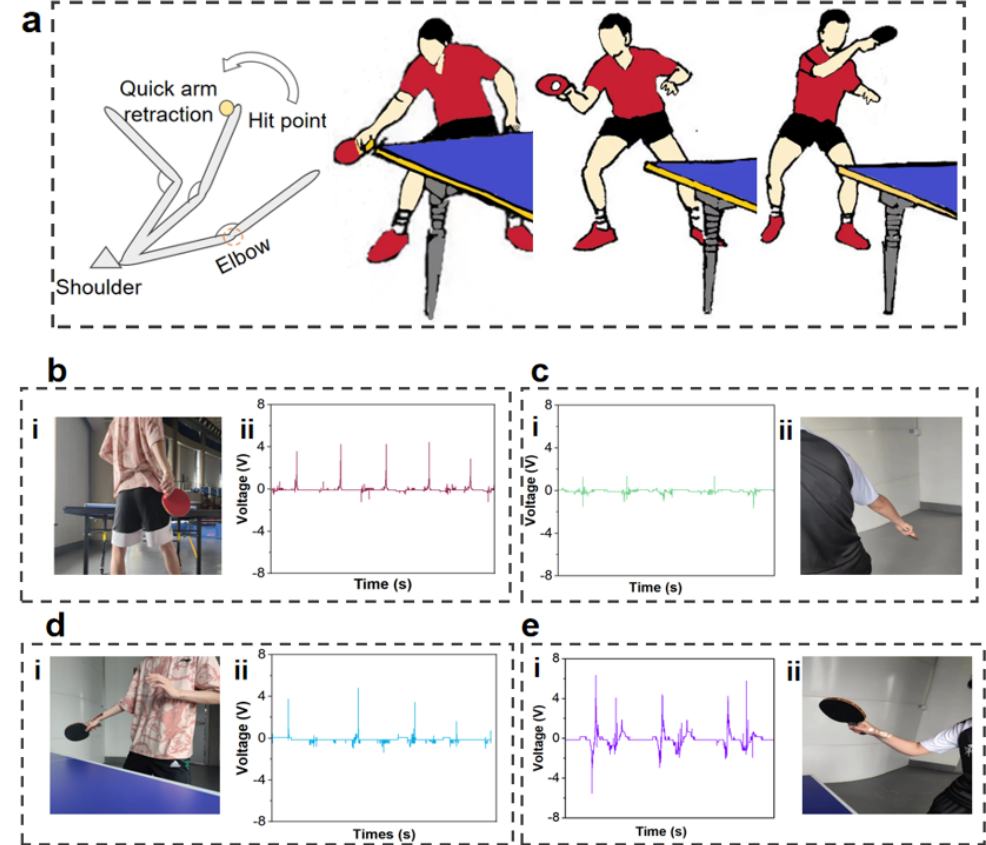
Figure 3. The application of LS-TENG in the forehand loop technique. ( a ) Schematic diagram of forehand loop technique. ( b ) Elbow state and output voltage of standard forehand loop technical action. (i) Elbow state diagram of standard forehand loop technical action. (ii) The output voltage of the elbow of the standard forehand loop technique action. (c) Elbow state and output voltage of the wrong forehand loop technique. (i) The output voltage of the elbow of the wrong forehand loop technique action. (ii) Schematic diagram of elbow state of wrong forehand loop technical action. (d) The wrist state and output voltage of the standard forehand loop technical action. (i) Wrist state diagram of standard forehand loop technical action. (ii) The output voltage of the wrist of the standard forehand loop technique action. ( e ) Wrist state and output voltage of the wrong forehand loop technique. (i) The output voltage of the wrist of the wrong forehand loop technique action. (ii) Schematic diagram of wrist state of wrong forehand loop technical action.